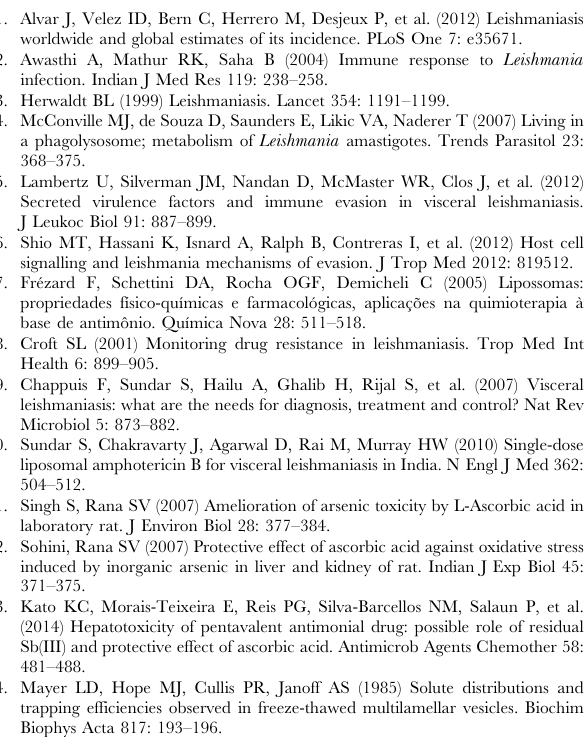
Figure S2. Ex vivo immunophenotyping of T lympho- cytes from L. infantum infected mice submitted to treatment regimens. (PBS: A-C) phosphate-buffered, (Sb: D) saline trivalent antimony, (Empty Lipo: E) empty liposomes, (Sb Lipo: F) antimony entrapped liposomes, (AA: G) ascorbic acid, (AA + Sb: H) ascorbic acid in association with antimony, (AA + Sb Lipo: I) ascorbic acid in association with antimony entrapped liposomes. (A) Size and granularity profiles of lymphocytes. (B) Granularity profile of CD3 + cells. (C-I) Profile of T CD8 + and Percentage of T (CD8 + ) lymphocytes. In (J) results are represented as mean 6 SD whereas for (K) as median 6 interquartile range of two independent experiments. No statistically significant differ- ences were observed. Figure S3. Ex vivo immunophenotyping of B lympho- cytes from L. infantum infected mice submitted to treatment regimens. (PBS: A-B) phosphate-buffered, (Sb: C) saline trivalent antimony, (Empty Lipo: D) empty liposomes, (Sb Lipo: E) antimony entrapped liposomes, (AA: F) ascorbic acid, (AA + Sb: G) ascorbic acid in association with antimony, (AA + Sb Lipo: H) ascorbic acid in association with antimony entrapped liposomes. (A) Size and granularity profiles of lymphocytes. (B-H) Granularity profile of CD19 + cells. (I) Percentage of B (CD19 + ) lymphocytes. In (I) results are represented as mean 6 SD of two independent experiments. No statistically significant differences were observed.